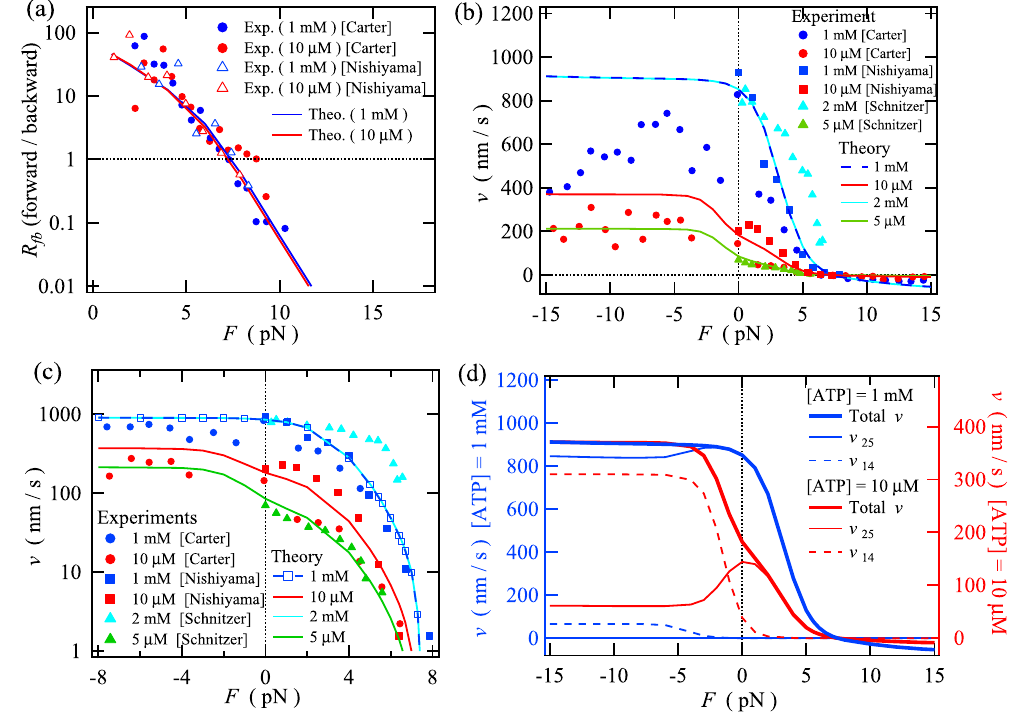
Figure 3. Force dependences of ( a ) the ratio of forward to backward steps, ( b ) and ( c ) the motor velocity [( b ) and ( c ) show the same data, plotted on linear and logarithmic scales, respectively], and ( d ) contributions to the total velocity v from the steady-state excess local fluxes between states 2 and 5, = ∆ v l J st and 4, = ∆ v l J st . The experimental data are from the literature 12, 48, 49 . In ( d ), the velocities at ATP 14 14 concentrations of 1 mM and 10 μ M are shown on the left and right axes,